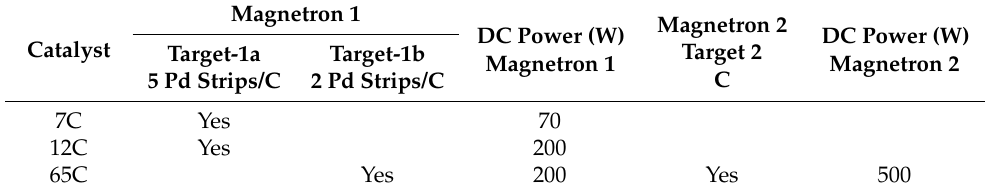
Table 1. MS deposition conditions for catalyst